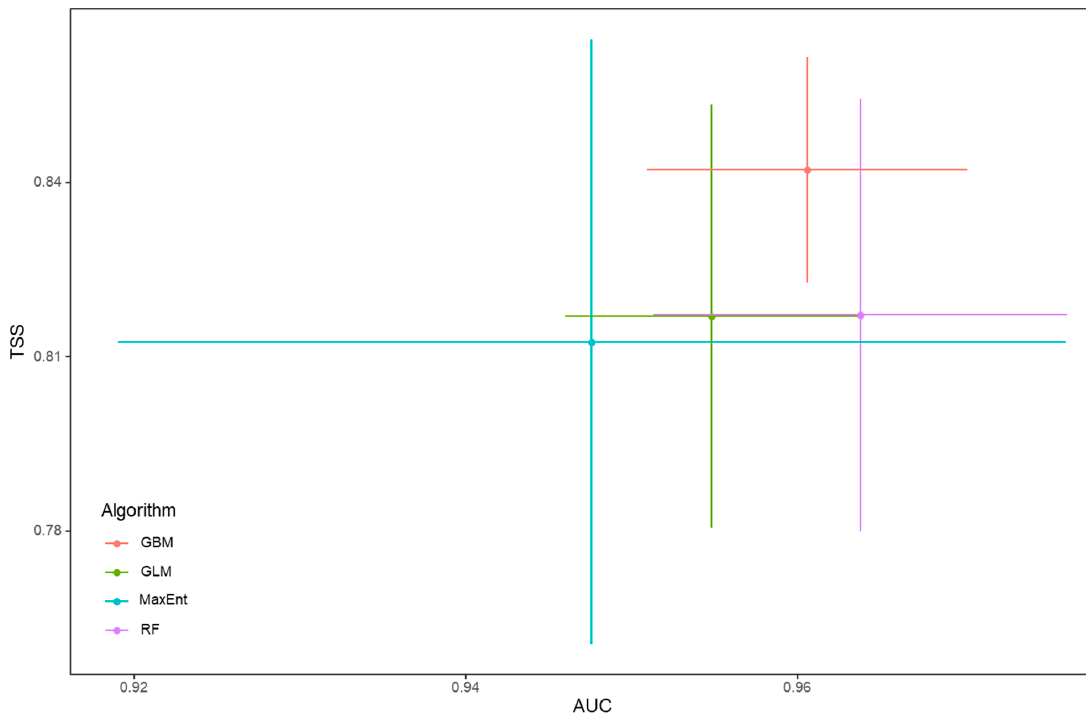
Figure 1. The performance of individual algorithms indicated by AUC and TSS.